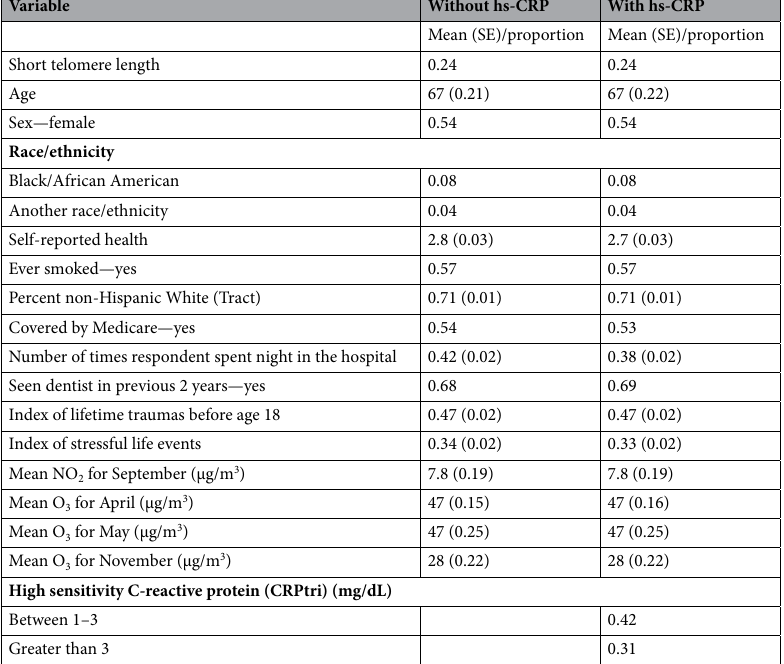
Table 1. Survey-weighted descriptive statistics for analytic sample. hs-CRP high sensitivity C-reactive protein, SE standard error. n = 4,206 for analytical sample without hs-CRP and n = 3,761 for analytical sample with hs-CRP.